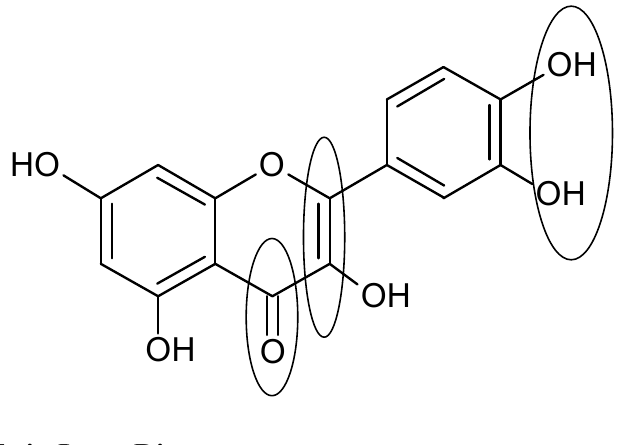
Figure 4. Structure of quercetin as example of important requisites (unsaturation in the C ring, number and position of hydroxyl groups at ring B, carbonyl group at C-4 and non- glycosylation) for anti-inflammatory activity of